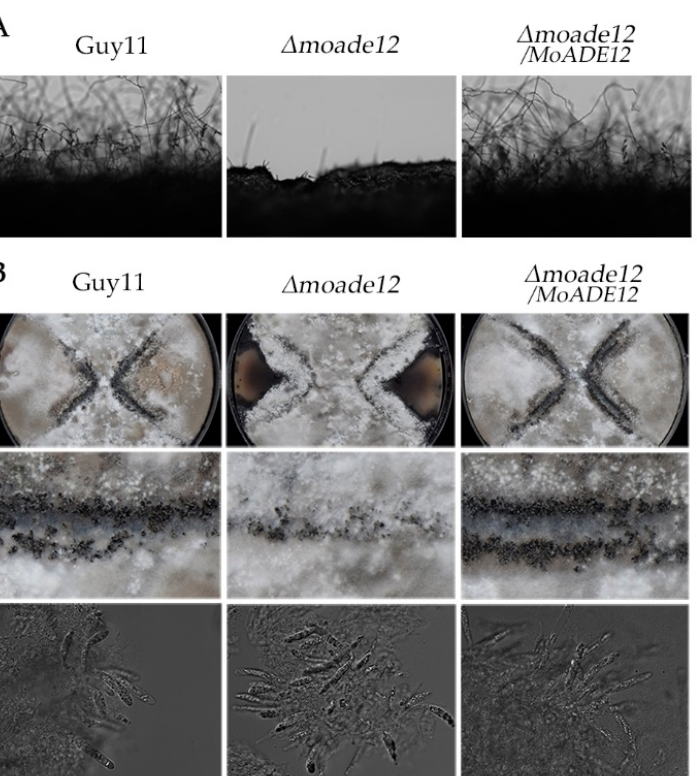
Figure 2. The ∆ moade12 mutant showed defects in asexual and sexual development. ( A ) Conidial development was examined under a light microscope at 20 h after induction on glass slides. ( B ) Perithecia (Rows 1 and 2) and asci (Row 3) formed by the indicated strains were photographed 3 weeks after inoculation. The white scale bar represents 20 µ m. For sexual development, the tested strains and mating partner strain TH3 were in- oculated onto OMA plates and cultured at 20 ◦ C for three weeks. The results showed that the ∆ moade12 mutant produced perithecia, and the ability of the ∆ moade12 mutant to produce perithecia was visibly reduced compared that of the wild type and complemented transformant (Figure 2B). However, mature perithecia and asci were observed under the microscope in the ∆ moade12 mutant (Figure 2B). These results above indicate that MoADE12 is essential for asexual development, and plays a role in sexual reproduction in M. oryzae .